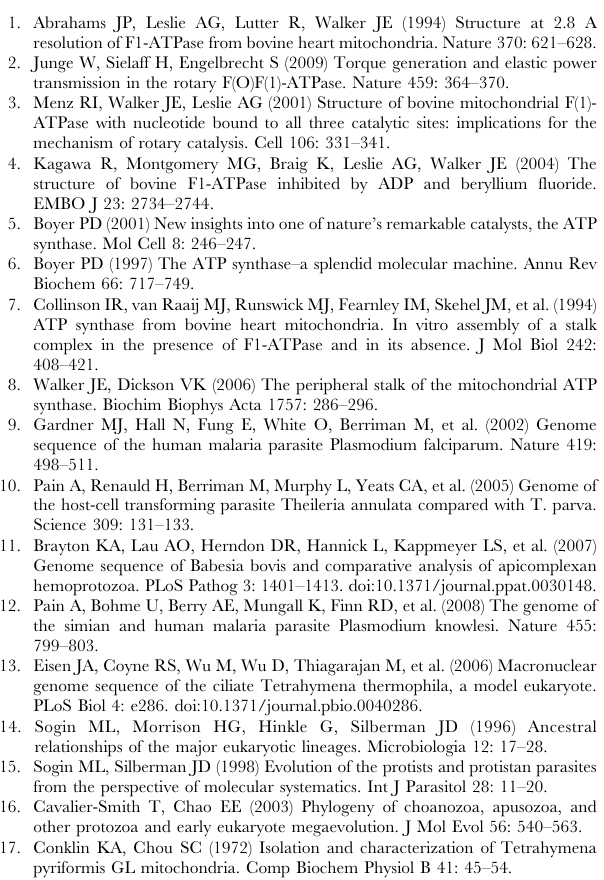
Table S5 gi identification numbers of proteins used in phylogenetic analyses. Found at: doi:10.1371/journal.pbio.1000418.s010 (0.04 MB XLS) Text S1 Supplemental results: proposed revision of gi:118355322/trembl:Q22ZH1/Hypothetical